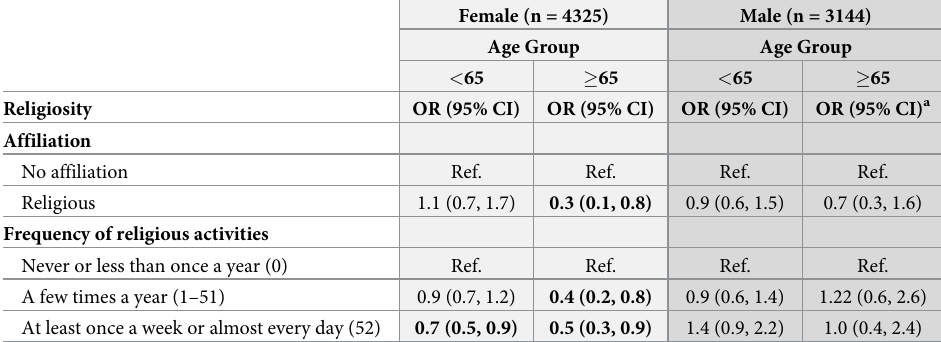
Table 3. Association between religiosity and Major Depressive Episode by age